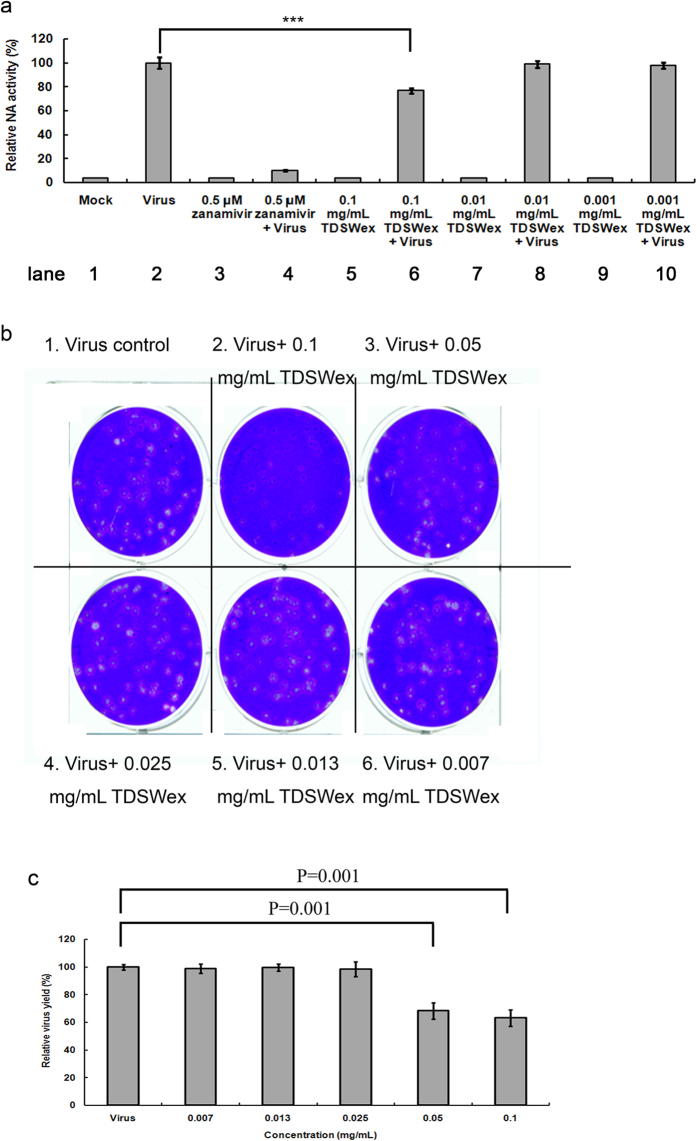
NA assay and plaque reduction assay.(a) NA assay. Influenza A/WSN/33 was incubated with TDSWex or zanamivir for 30 min before addition of MU-NANA (60 μM) and then incubated at 37 °C for 1 h. The controls were mock mixed with DMSO (0.3%) or virus mixed with DMSO (0.3%). The results are presented as ratios of relative NA activity ± SD from three independent experiments. (b) Plaque reduction assay. MDCK cells were infected with influenza A/WSN/33 and the infected cells were then maintained and overlaid with 0.3% agarose containing the indicated concentrations of TDSWex. The number of plaques was calculated on the right. The data are presented as means ± SD of results from three independent experiments. ***P < 0.001.